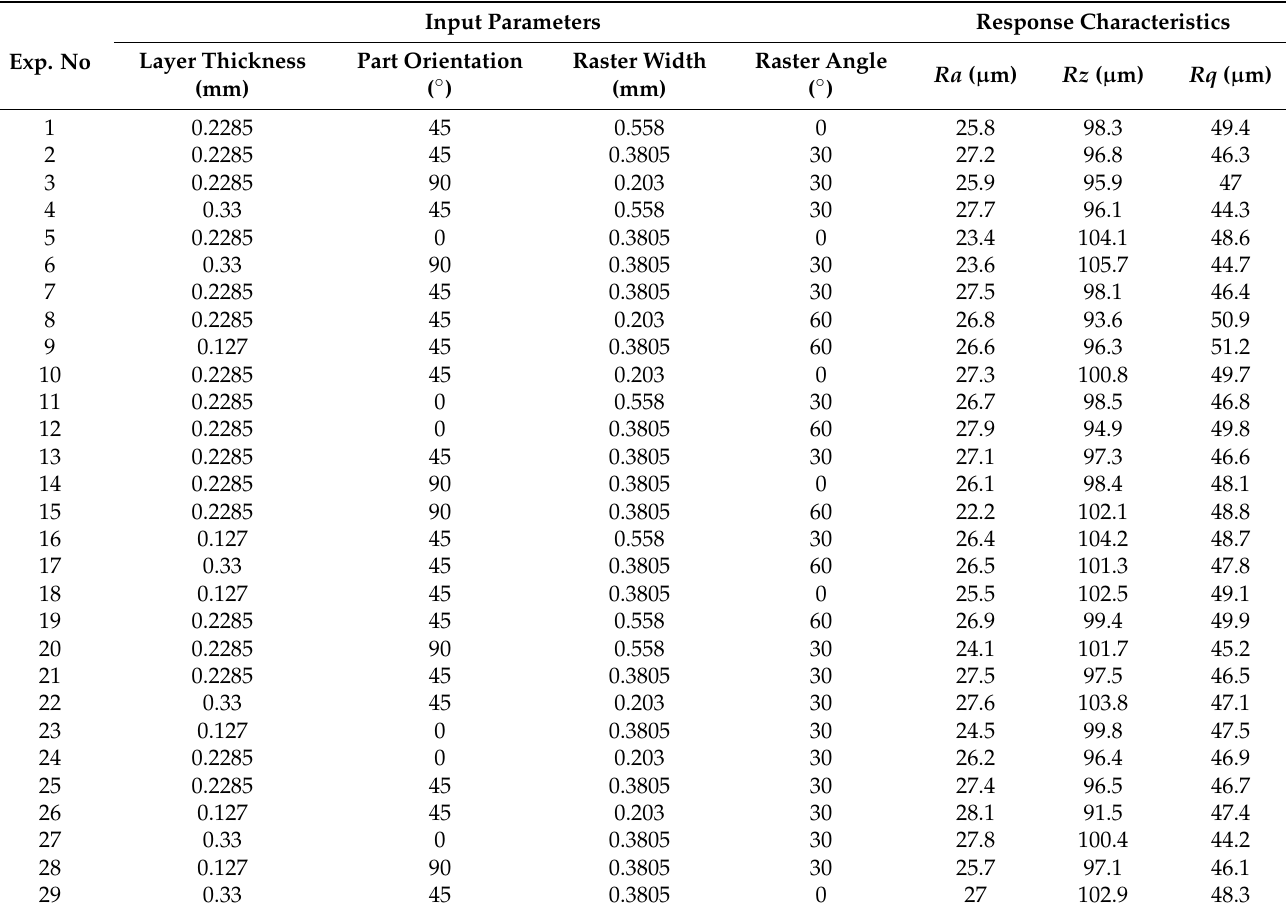
Table 2. FDM experimental design and measured